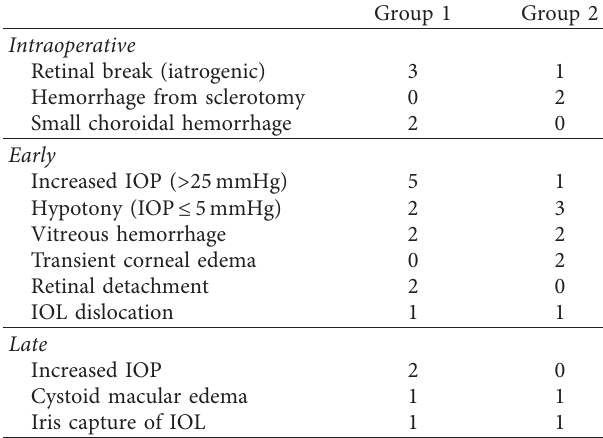
Table 3: Intraoperative, early, and late complications of the two